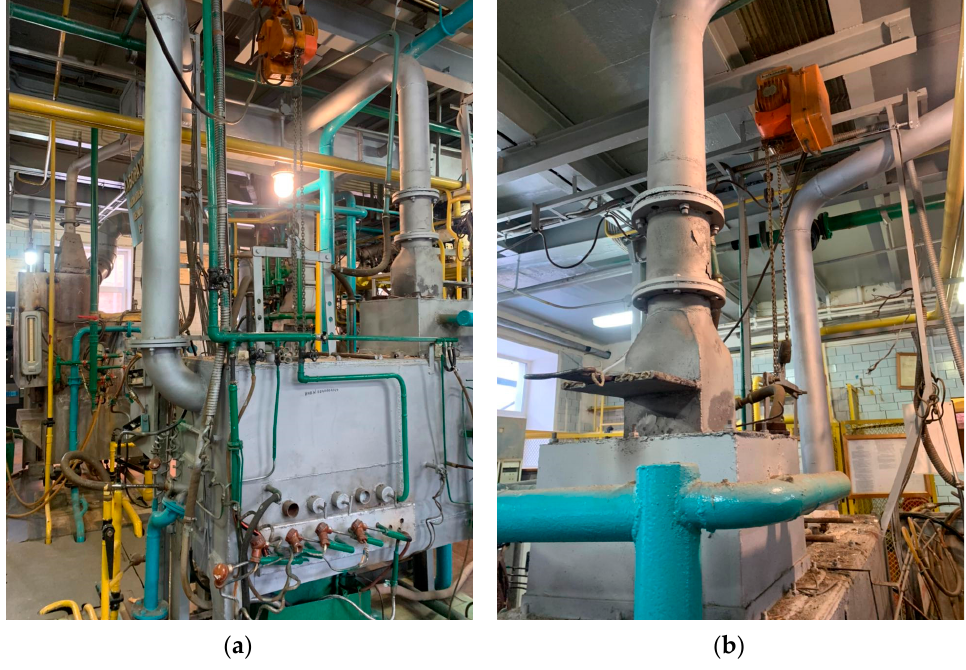
Figure 1. Natural gas furnace: ( a ) General view; ( b ) Chimney.